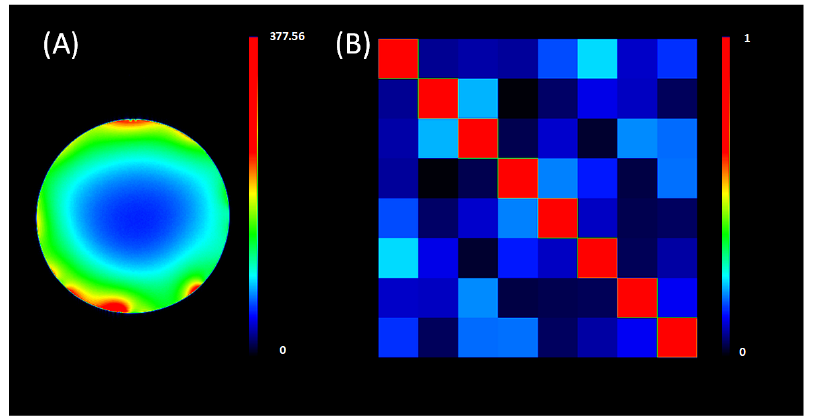
Figure 5. Normobaric 3 Tesla MR image quality tests [25] of a saline phantom: ( A ) signal-to-noise ratio and ( B ) noise covariance matrix.